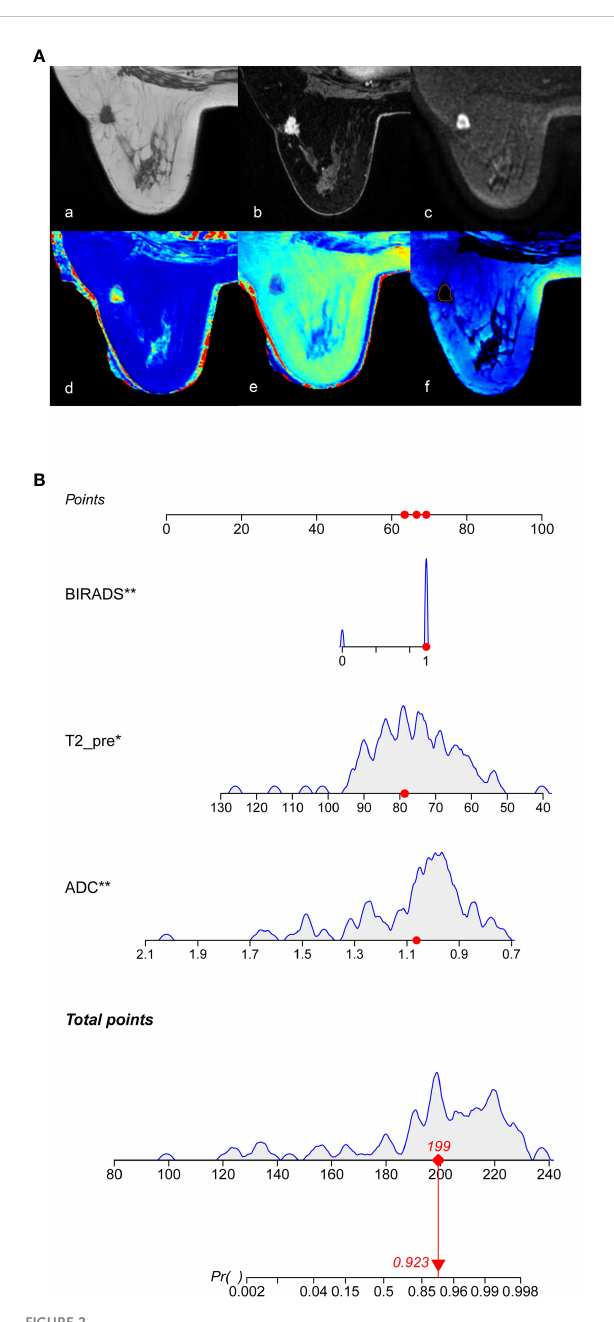
FIGURE 2 Nomogram for the diagnosis of benign and malignant breast lesions. (A) 37-year-old woman with a non-speci fi c invasive ductal carcinoma, image with T2WI (A-a), DCE-MRI (A-b), MUSE-DWI (A-c), T1 map (A- d), T2 map (A-e), PD map (A-f). BI-RADS 4c=1 (i.e., malignancy could not be excluded, classi fi ed as malignant), T2 pre = 78.67 ms, ADC = 1.06×10 -3 mm 2 /s. According to Nomograms (B) , total points was 199 points and the possibility of malignancy was about